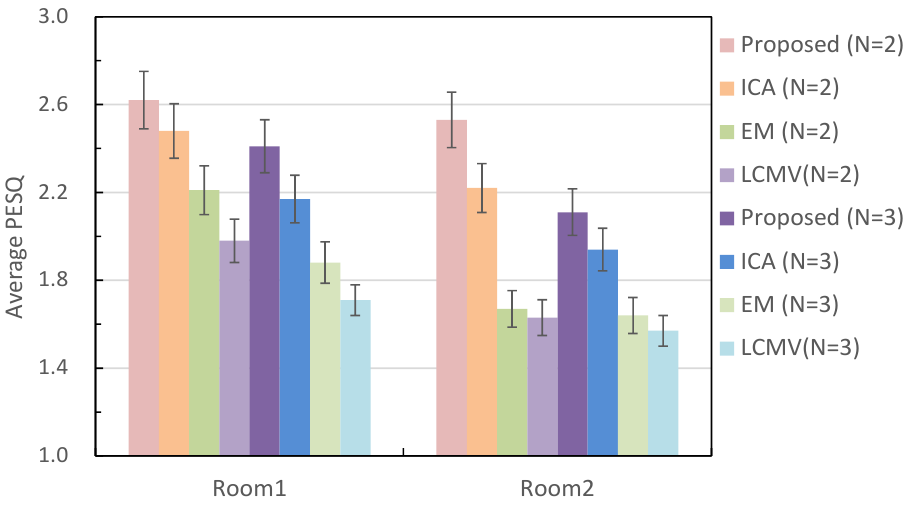
Figure 11. Average PESQ in different reverberant rooms.